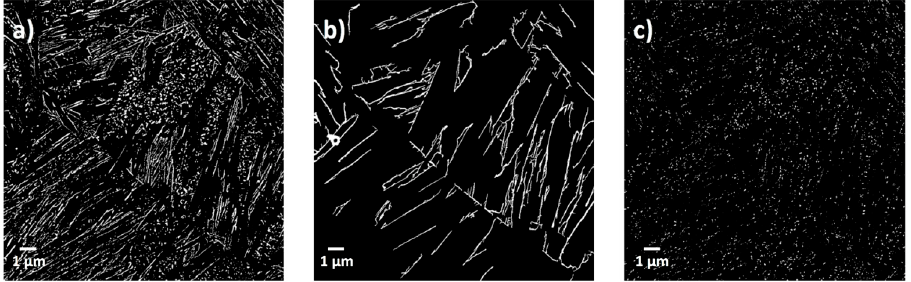
Figure 4. ( a ) Binary image of SEM micrograph in Figure 3. Figure 4b,c were segmented from Figure